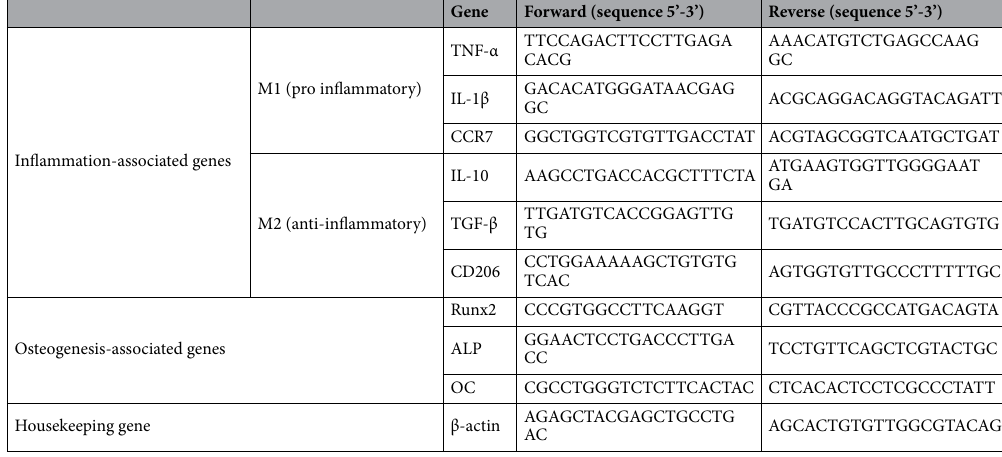
Table 1. List of primer sequences used for the gene expression